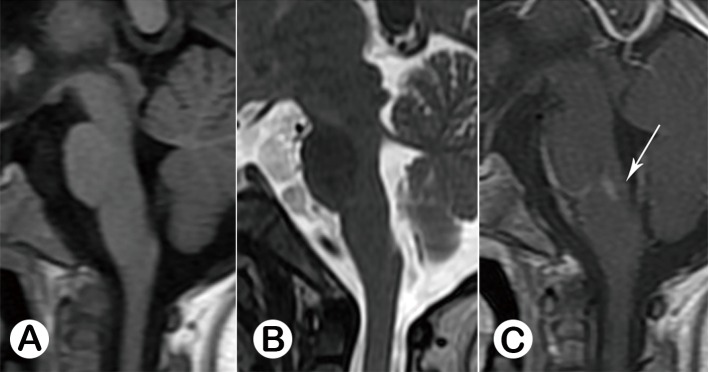
Acute stage type Ⅲ, Female, 2.5 years old, on the 7th day of the disease.There was no abnormal signal at the brainstem seen from sagittal T1WI (A) and T2WI (B); Post-contrast sagittal T1WI demonstrated a patchy, moderate enhancement region (C, white arrow).